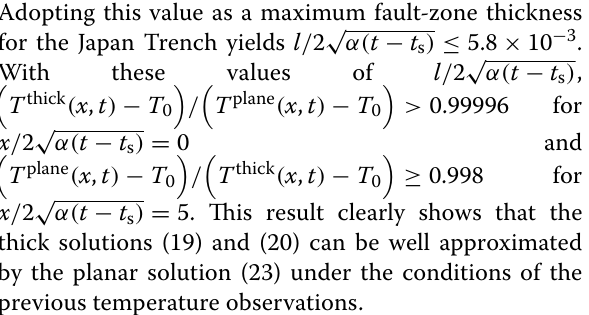
Fig. 5 Comparison of the thick solution T thick and the planar solution T plane . The ratio between and its deviation from unity are plotted against the nondimensional parameter l / 2 √ α( t respectively. The solutions were calculated using Eqs. (19), (20), and (23). The other nondimensional parameters were set to t s / t